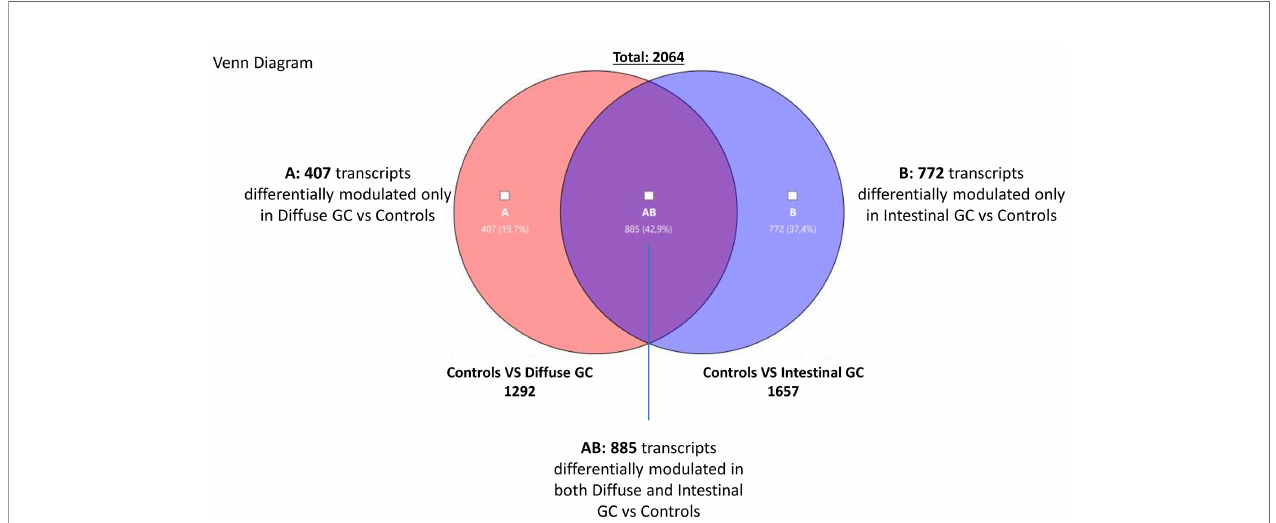
FIGURE 2 | Transcriptome analysis. Venn Diagram analysis of differentially expressed genes in Diffuse (subset A) and Intestinal (subset B) gastric cancer samples compared with healthy mucosa, showing the overlapping region (identi fi ed AB subset) containing transcripts differentially expressed in both gastric cancer histotypes (Fold Change < − 2 or >+2, p value <